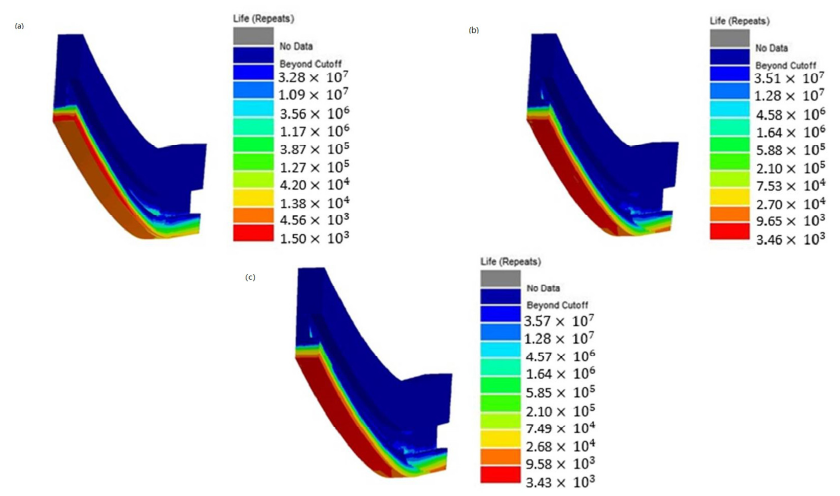
Figure 17 . Service life: ( a ) first cycle (𝑁 (cid:2869) ) , ( b ) second cycle (𝑁 (cid:2870) ) , ( c ) third cycle (𝑁 (cid:2871) )